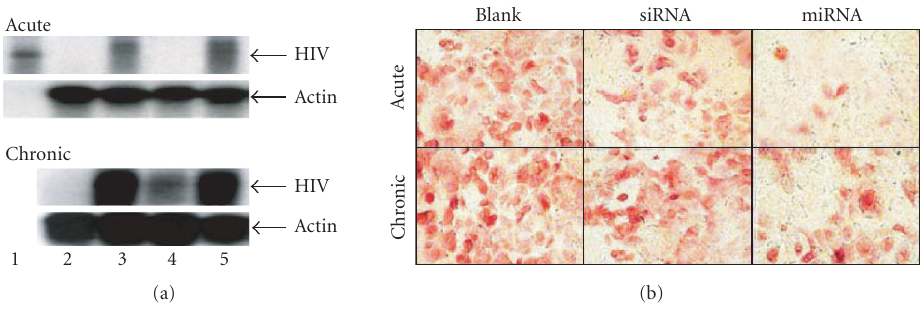
Figure 5: Silencing of HIV-1 genome replication using anti- gag/pro/pol miRNA transfection into CD4 + T lymphocytes isolated from the acute and chronic phases of AIDS infections. (a) Northern blot analysis showed about 98% and 70% decreases of HIV genome in the acute and chronic infections after miRNA treatments (lane 4), respectively. No e ff ect was detected in the T cells transfected with miRNA ∗ targeting the same gag/pro/pol region of the viral genome (lane 5). The size of pure HIV-1 provirus was about 9,700 nucleotide bases (lane 1). RNA extracts from normal noninfected CD4 + T lymphocytes were used as a negative control (lane 2), whereas those from HIV-infected T cells were used as a positive control (lane 3). (b) Immunostaining for HIV p24 marker confirmed the results in (a). Since the ex vivo HIV-silenced T lymphocytes were resistant to any further infection by the same strains of HIV, they may be transfused back to the donor patient for eliminating HIV-infected